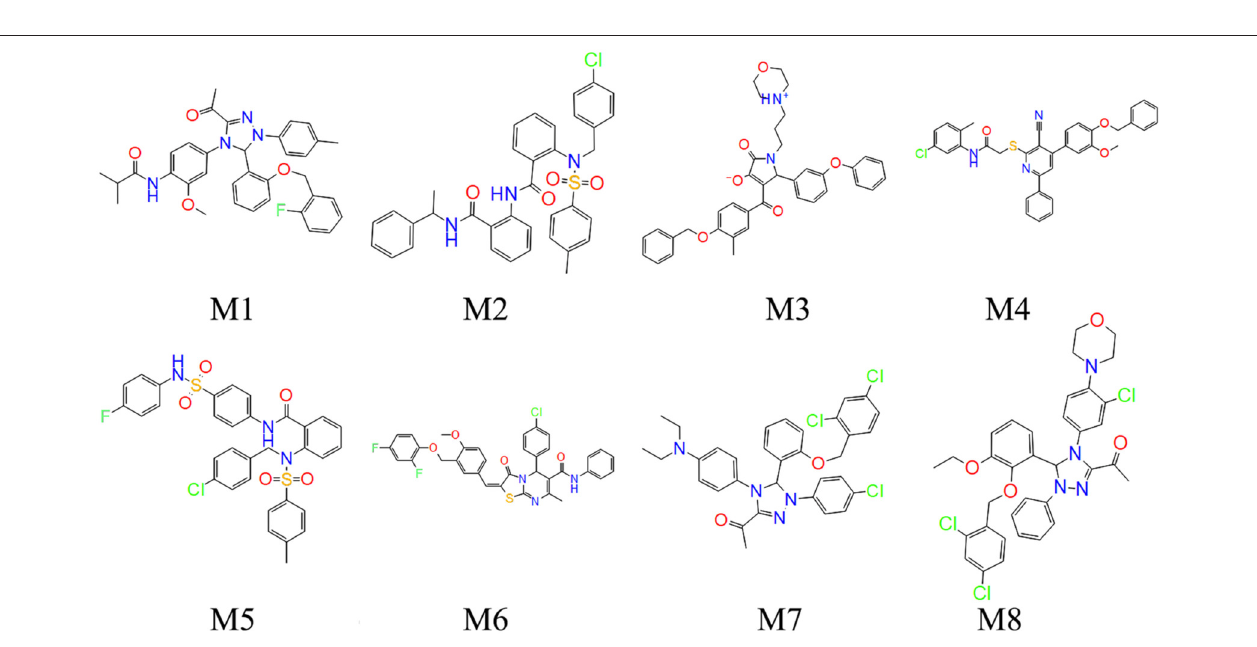
FIGURE 6 | Chemical structures of the compound M1-M8.